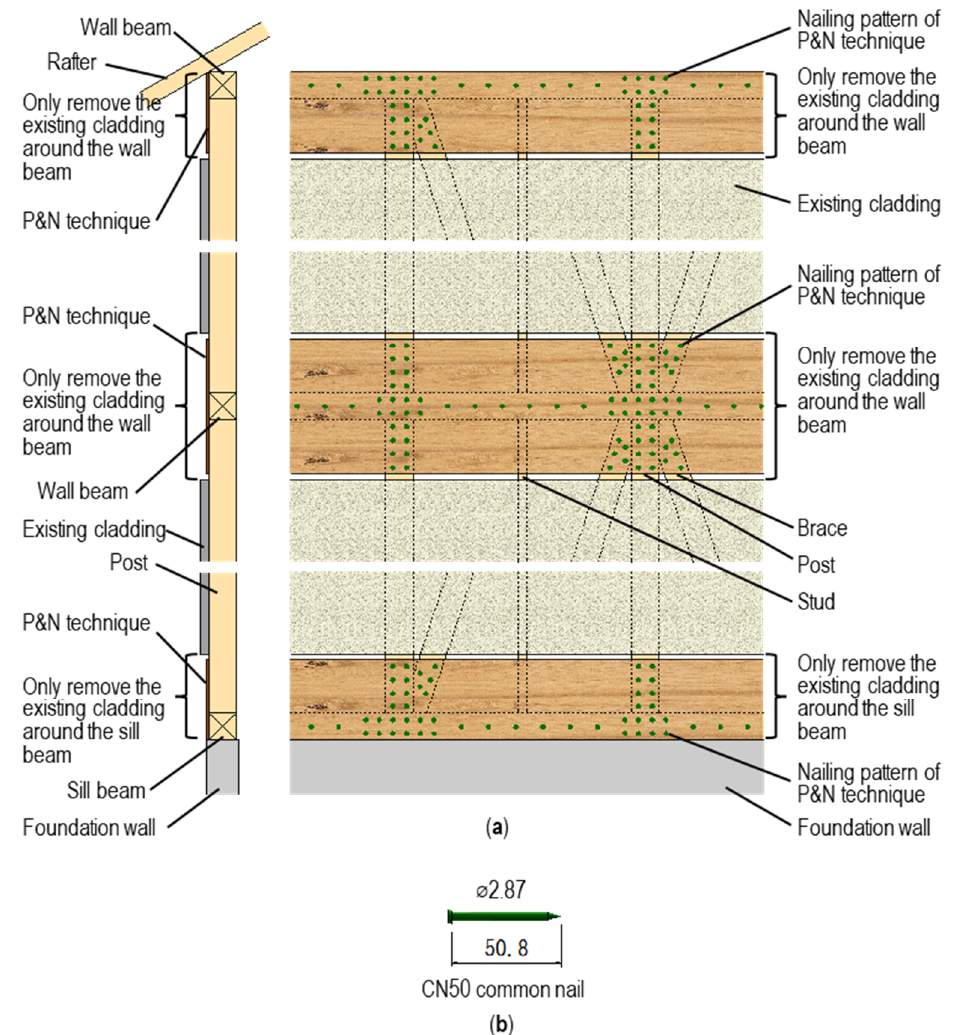
Figure 3. The P and N technique for a Japanese detached house: ( a ) typical retrofitting design for TF construction; ( b ) the specification of CN50 common nail; dimensions in mm.